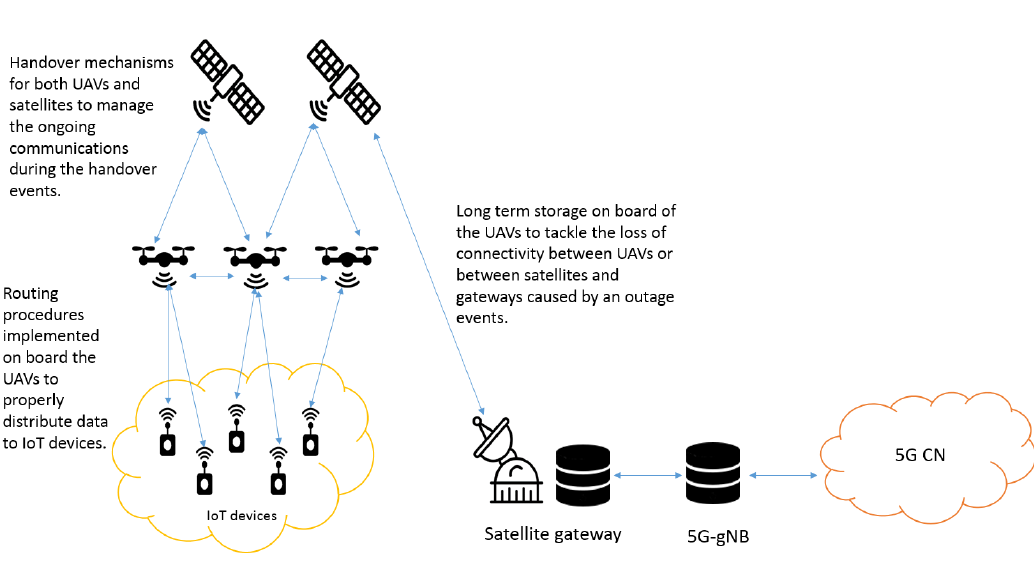
Figure 8. IoT device-UAV-satellite and 5G